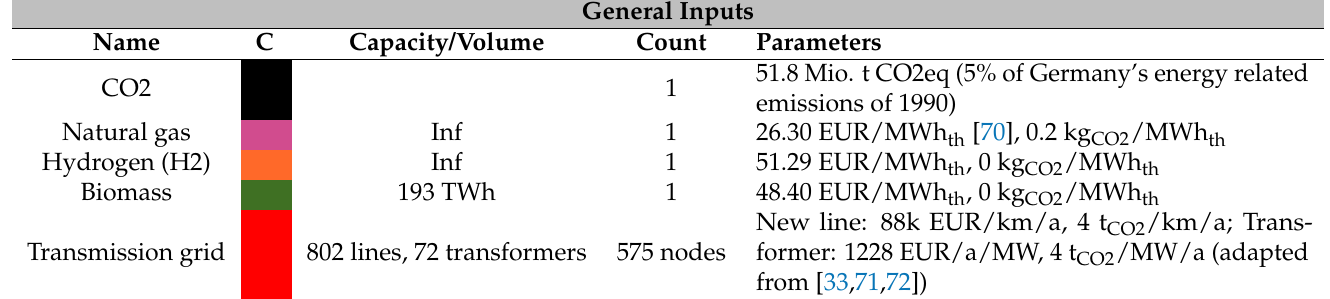
Table A3. Parameter table on general assumptions. General